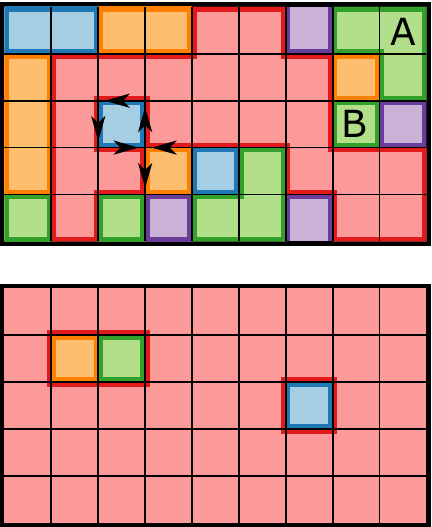
Figure 2. Interfaces for q square is a lattice site. Top: Arrows show the counter-clockwise path interface walker (for large cluster) takes around complex interactions. Labelled clusters, while sharing the same state, are disjoint, and thus have separate interfaces. Average interface length is ( 34 dominates, it no longer has an “outer” perimeter. Average interface length is ( 6